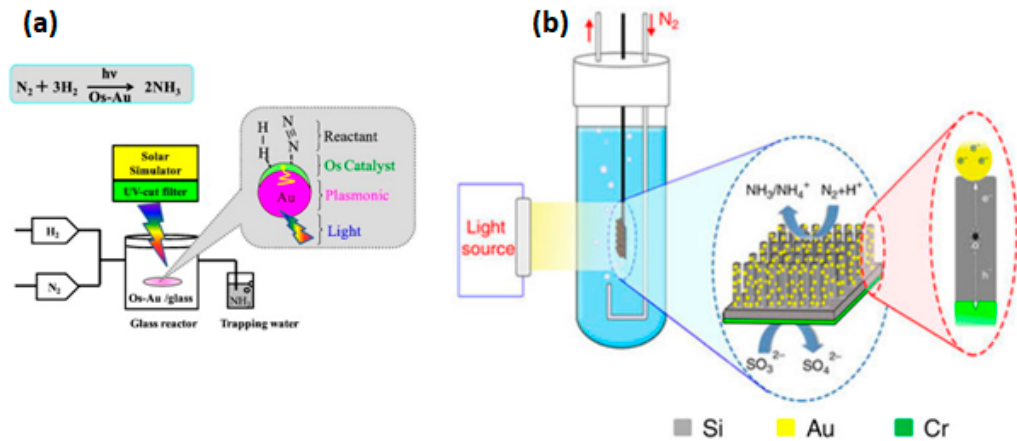
Figure 16. ( a ) A schematic illustration the mechanism of Au-Os nanocomposite for NH 3 photofixation [79]; ( b ) Schematic diagram of photochemical nitrogen reduction of Au/bSi/Cr [72]. (Reproduced with permission from the respective publishers).